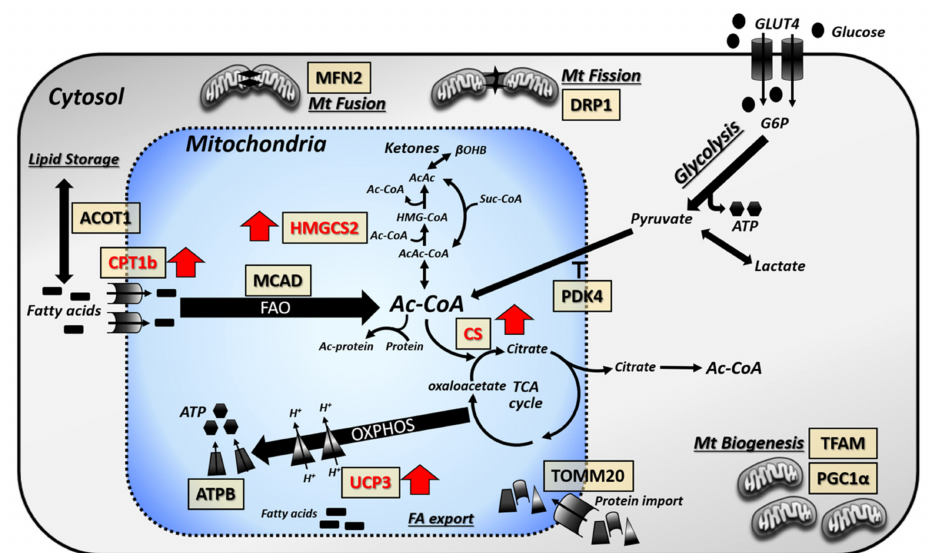
Figure 5. Schematic representation of metabolic protein changes induced by LAV-BPIFB4 . LAV-BPIFB4 treatment is associated with a subtle up-regulation in proteins involved in mitochondrial metabolism. Red arrows indicate the enzymes induced by LAV-BPIFB4